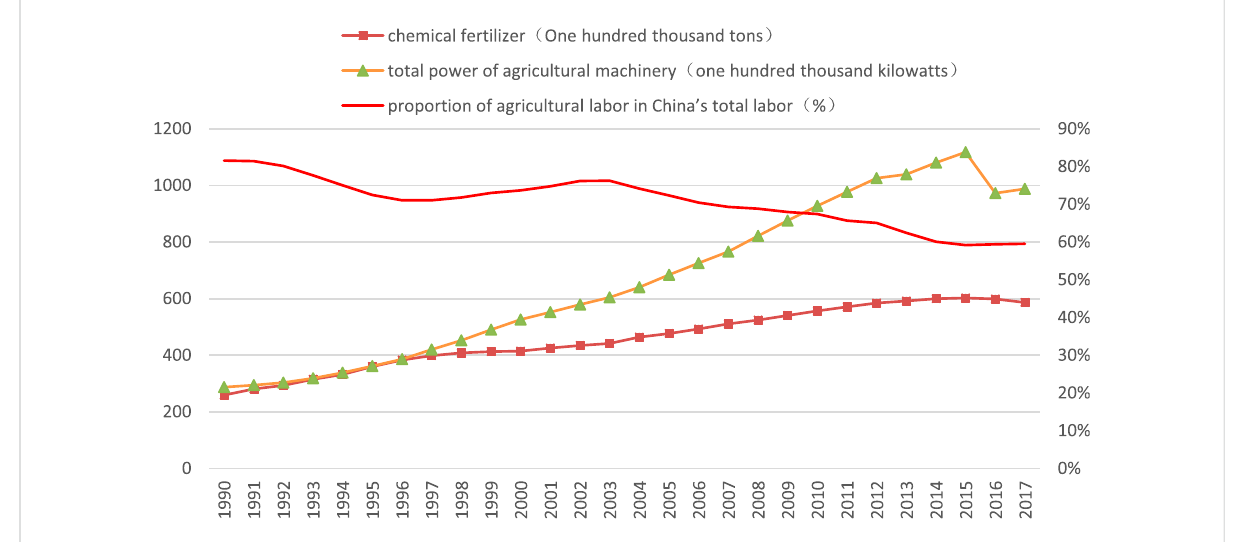
FIGURE 1 Change trend in ALT, fertilizer application and total power of agricultural machinery (1990 – 2017).